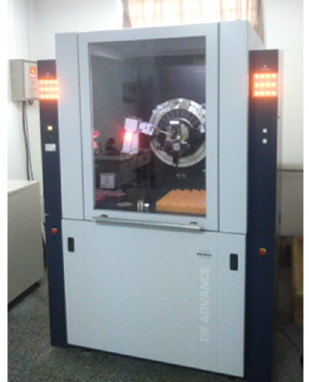
Figure 5. D8 ADVANCE X-ray diffractometer.